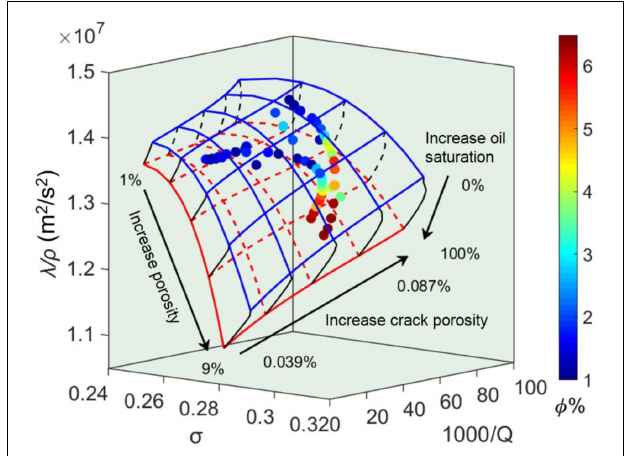
where the blue and red circles refer to the water- and oil-saturated samples, respectively. The average error between the